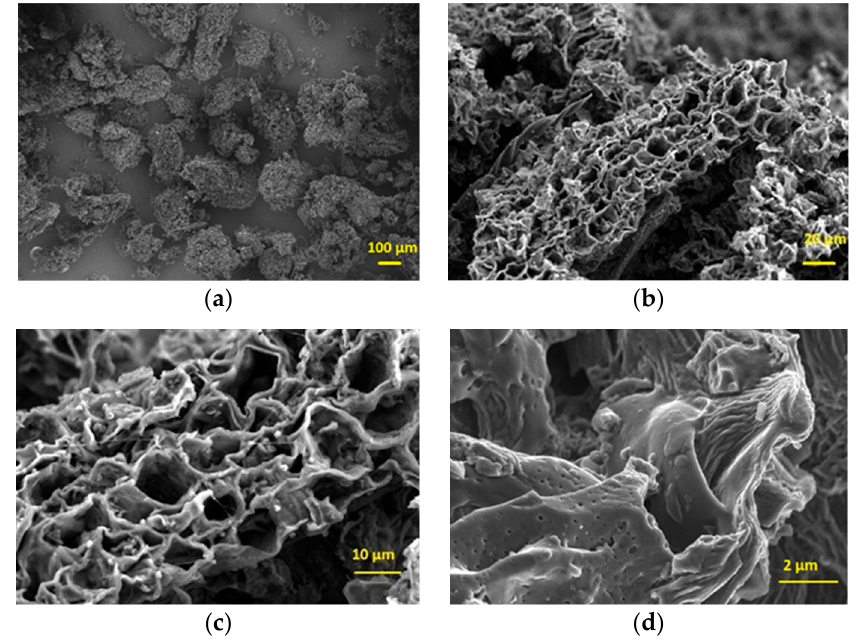
Figure 4. FE-SEM micrographs of the CGB powder at: ( a ) 150 × , ( b ) 1 k × , ( c ) 2.5 k × and ( d ) 15 k × magnification.